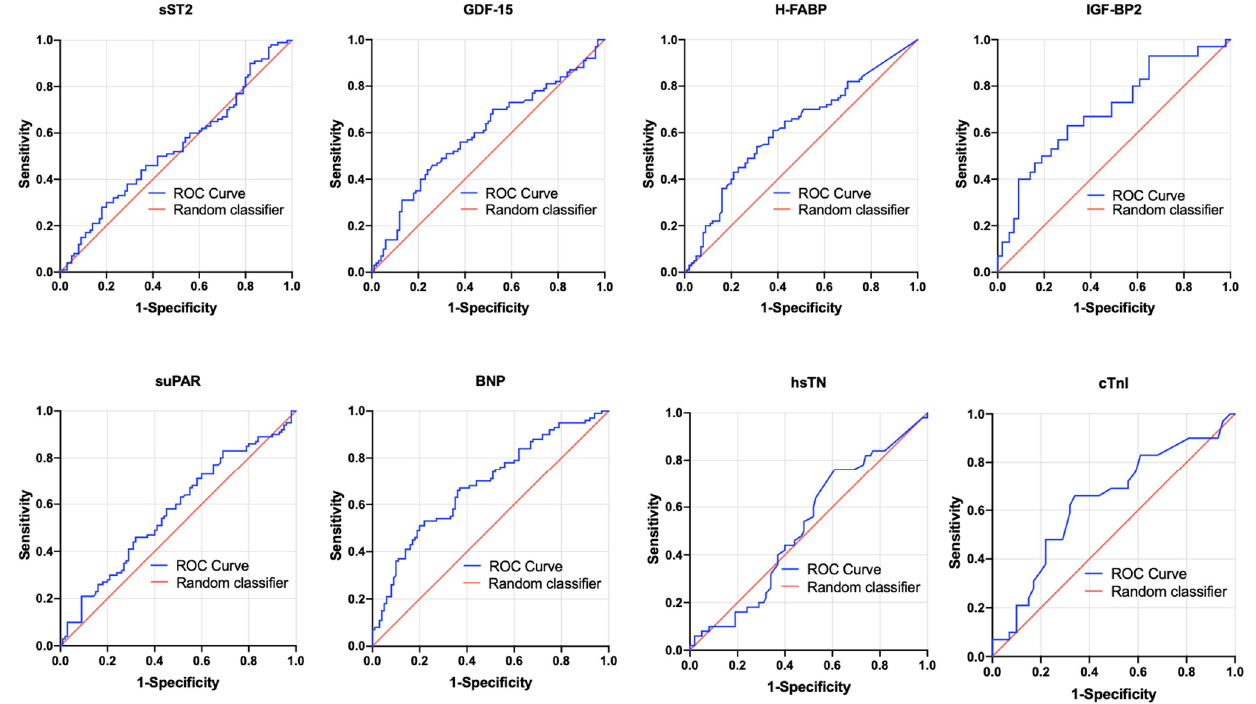
Figure 4. AUROC curves of sST2, GDF-15, H-FABP, IGF-BP2, suPAR, BNP, hsTN, and cTnI for prediction of a PA/BSA value ≥ 16.6 mm/m 2 with concerning cut-off values, Youden Indexes, sensitivity and specificity . BNP: brain natriuretic peptide; cTnI: cardiac troponin I; hsTN: high-sensitive troponin; sST2: soluble suppression of tumorigenesis-2; GDF-15: growth/differentiation factor-15; H-FABP: heart-type fatty acid-binding protein; IGF-BP2: insulin-like growth factor binding protein 2; suPAR: soluble urokinase-type plasminogen activator receptor. Table 4. Tabular overview of AUROC analyses of singular biomarkers for prediction of a PA/BSA With p -values ≤ 0.05, significant results were found for GDF-15 (AUROC = 0.595, value ≥ 16.6 mm/m 2 with concerning Youden Index, sensitivity, and specificity . 95%CI = 0.509–0.680, p = 0.029, sensitivity = 0.44, specificity = 0.76, YI = 0.20) with a cut-off value of 1172.0 pg/mL and for BNP (AUROC = 0.684, 95%CI = 0.604–0.764, p = <0.001, sensitivity = 0.51, specificity = 0.80, YI = 0.32) with a cut-off value of 2194.0 pg/mL. IGF- BP2 (AUROC = 0.694, 95%CI = 0.570–0.818, p = 0.05, sensitivity = 0.63, specificity =